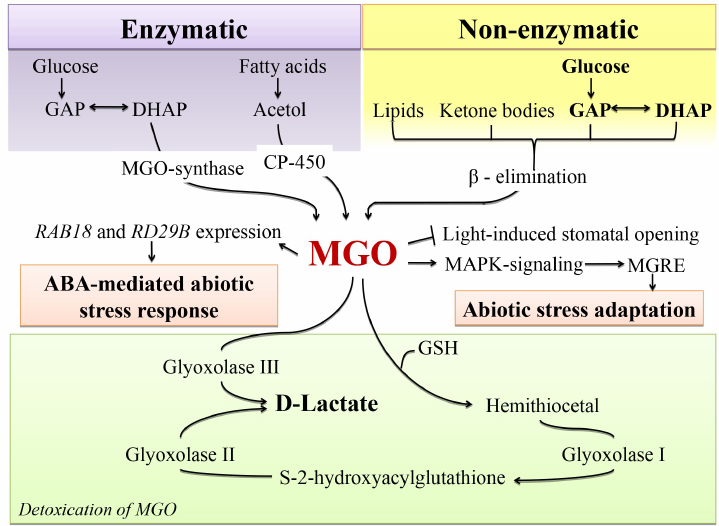
Figure3. ThepathwaysofMGOformation,detoxificationandsignallinginplantcells. MGO,methylglyoxal; Figure 3. The pathways of MGO formation, detoxification and signalling in plant cells. MGO, GAP, glyceraldehyde-3-phosphate; DHAP, dihydroxyacetone phosphate; ABA, abscisic acid; MGRE, methylglyoxal; GAP, glyceraldehyde-3-phosphate; DHAP, dihydroxyacetone phosphate; ABA, methylglyoxal responsive element; GSH, glutathione. Arrows and T-bars represent stimulatory and abscisic acid; MGRE, methylglyoxal responsive element; GSH, glutathione. Arrows and T-bars inhibitory e ff ects, represent stimulatory and inhibitory effects, respectively.